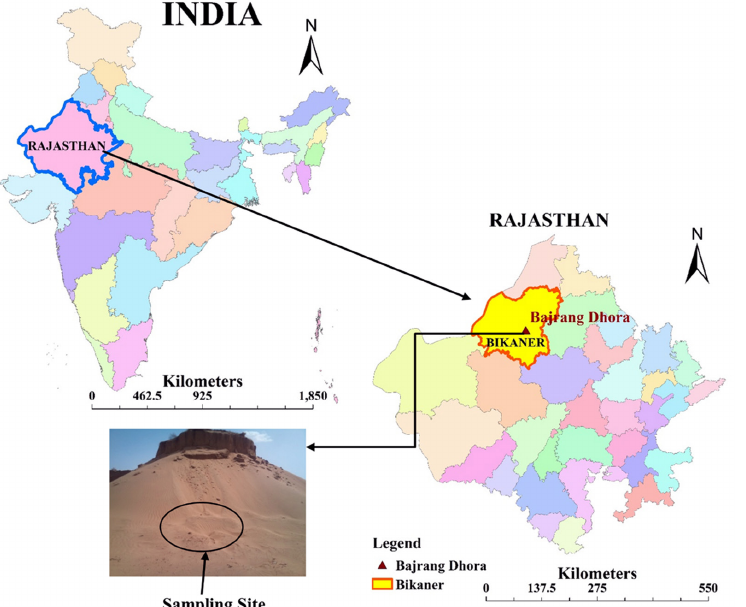
Fig. 1. Location of sampling sites at Bajrang Dhora, Thar Desert, Bikaner, Rajasthan, India. (Outline map source: Google